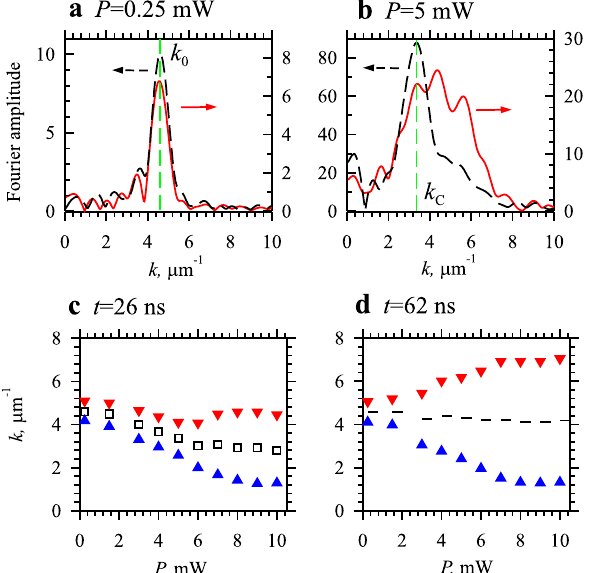
Figure 3. Analysis of the nonlinear phase modulation in the k-space. ( a ) and ( b ) Representative Fourier spectra of the spin-wave pulse obtained at P = 0.25 and 5 mW, respectively. Dashed and solid curves show the spectra corresponding to the initial propagation stage ( t = 26 ns) and the final stage ( t = 62 ns), respectively. ( c ) and ( d ) Power dependence of the spectral characteristics of the pulse at the initial and the final propagation stage, respectively. Squares−center wavenumber of the spectral peak. Point-up and point-down triangles−the lower and the upper boundaries of the spectrum measured at one half of the maximum amplitude. Dashes−center of mass of the